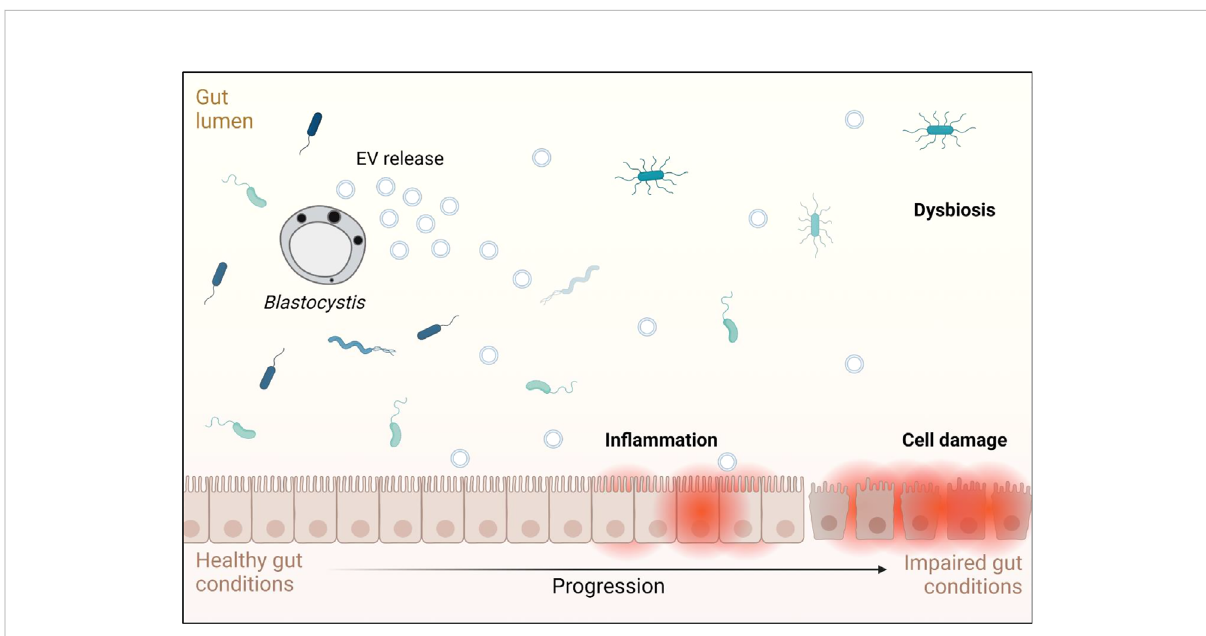
FIGURE 6 Graphical representation of the effects Blastocystis EVs may have on a human host, based on the results observed in this study and on conditions associated with Blastocystis infection. Adapted from “ Impaired Gut Membrane ” , by BioRender.com (2022). Retrieved from